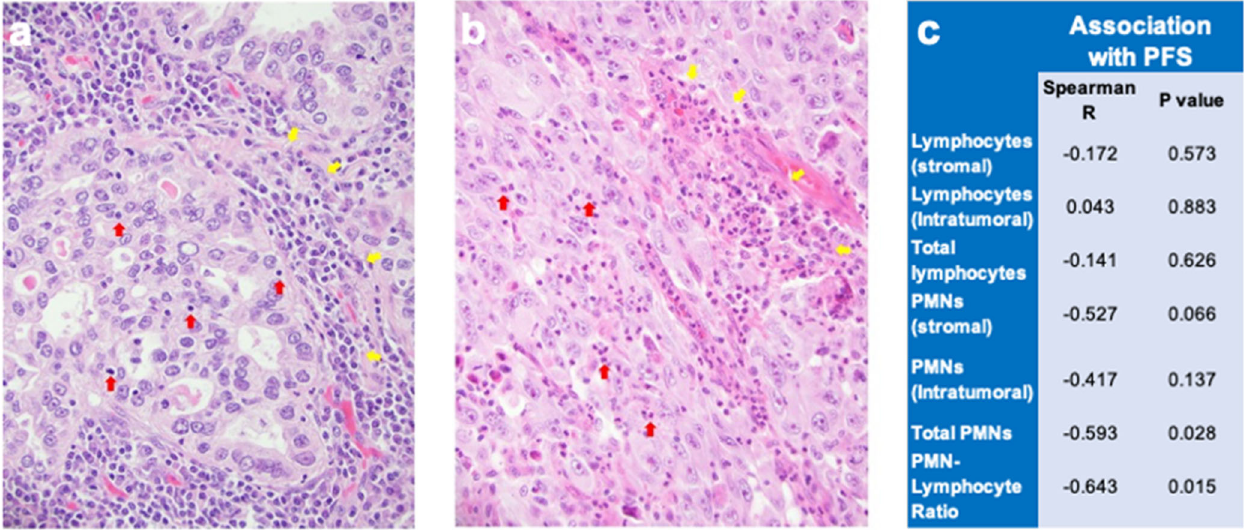
Fig. 7 Lymphocytes and polymorphonuclear neutrophil (PMN) quanti fi cation in ALK + patient pre-treatment biopsies and correlation with PFS. Representative images are shown of H&E-stained pre-treatment biopsies from ALK + lung cancer patients indicating tumor- in fi ltrating lymphocytes ( a ) and PMNs ( b ). In a , tumor-in fi ltrating lymphocytes (LCs) including tumor stromal LCs (yellow arrows) and intratumoral LCs (red arrows) are indicated. In b , tumor-in fi ltrating PMNs including tumor stromal PMNs (yellow arrows) and intratumoral PMNs (red arrows) are shown. c Spearman correlation analysis of PFS with pre-treatment tumor content of lymphocytes and PMNs and the PMN/lymphocyte ratio is